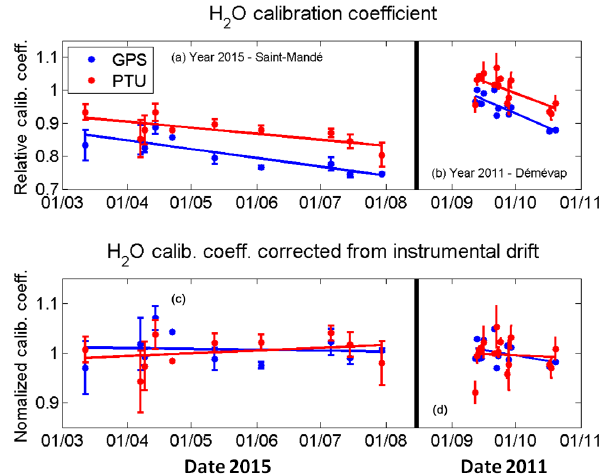
Figure 12. (a, b) Time series of lidar calibration factors determined with the GPS method (blue) and the PTU method (red). (c, d) cal- ibration factors after correction of a linear drift fitted from the N 2 calibration results (350–450m layer). The results from the Saint- Mandé campaign are plotted on the left part and the results from the DEMEVAP campaign on the right